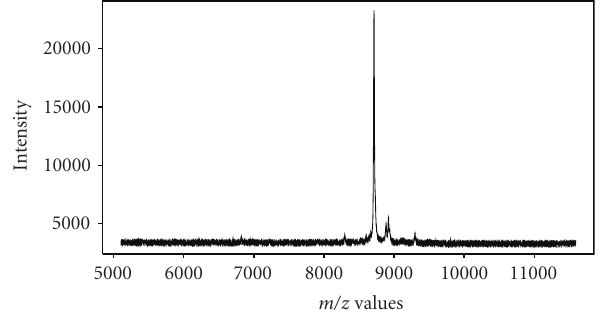
Figure 2: Mass Spectrometry: The spectrum contains various kinds of noise that must be addressed via low-level analysis techniques. The focus of this paper addresses peak detection and quantification from such